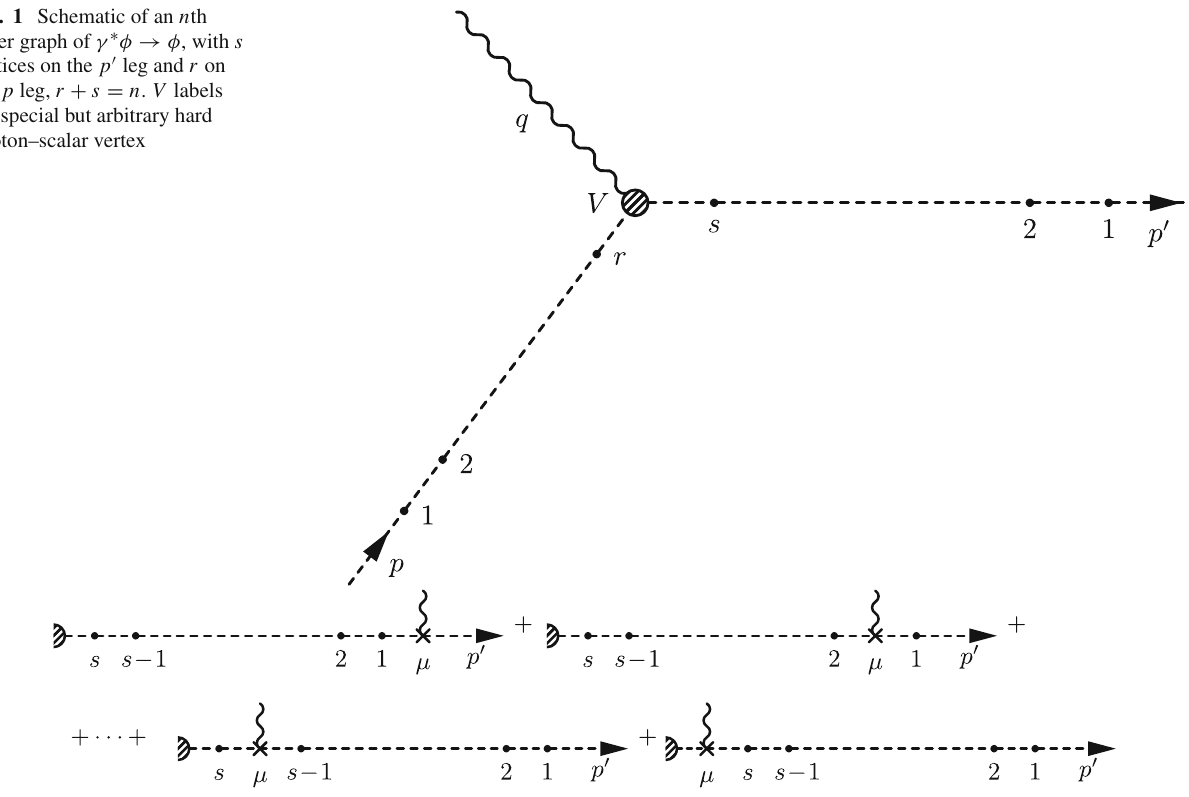
Fig. 1 Schematic of an n th order graph of γ ∗ φ → φ , with s vertices on the p (cid:8) leg and r on the p leg, r + s = n . V labels